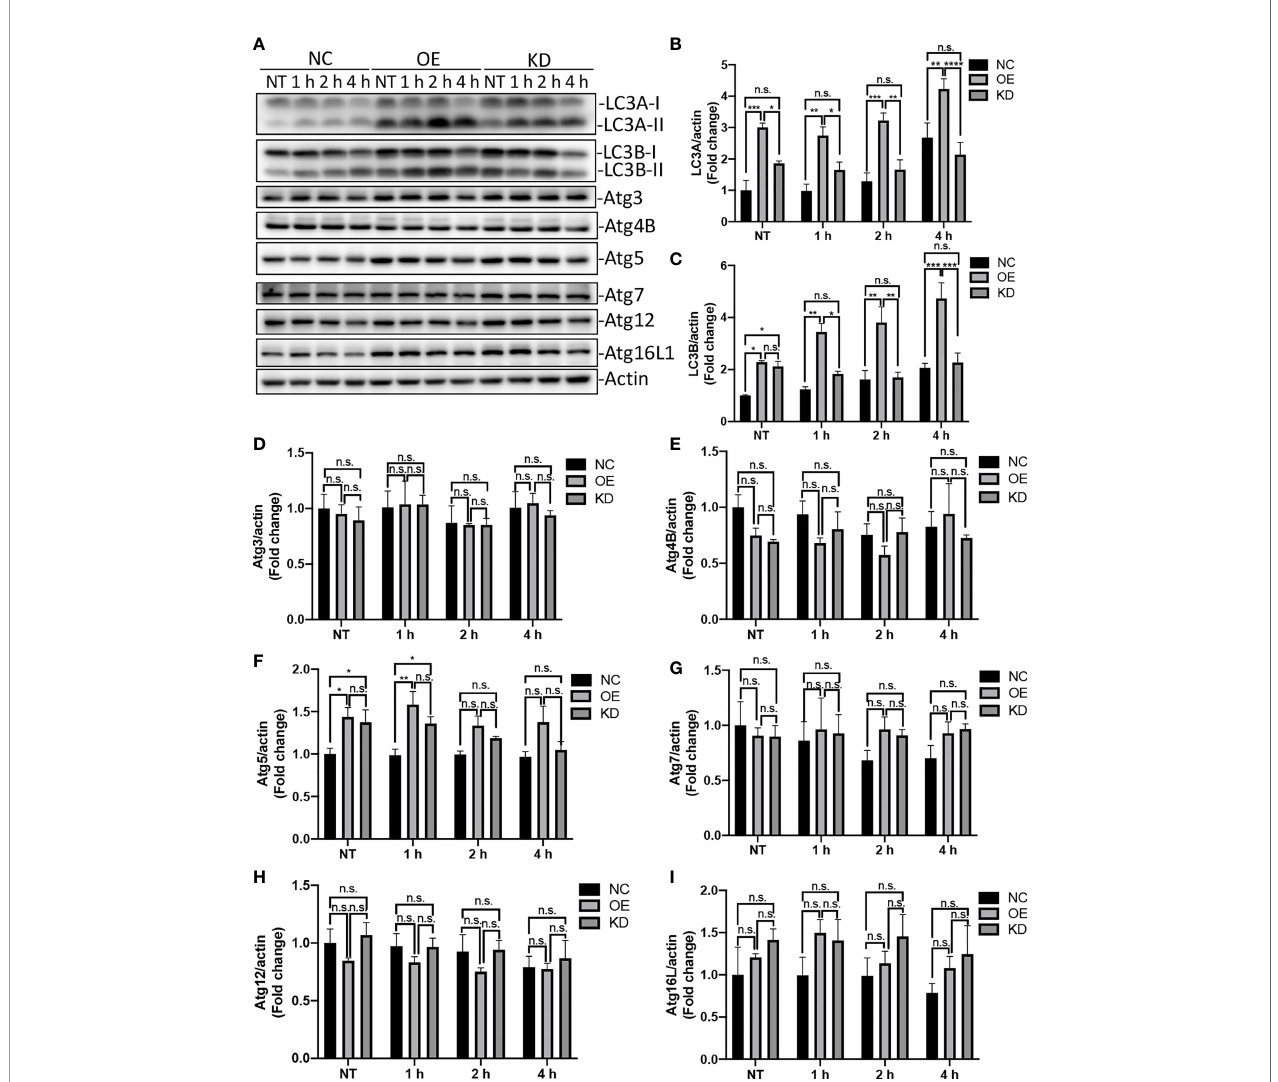
FIGURE 3 | Egr-1 upregulated expression of autophagy-related proteins in macrophages during P. aeruginosa infection. Egr-1 NC, OE and KD RAW264.7 cells were infected with P. aeruginosa PAO1 at an MOI of 10 for 1 h, 2 h, 4 h or left untreated (NT). Cell lysates were subjected to Western blotting for determining the protein expression levels of LC3A, LC3B, Atg3, Atg4B, Atg5, Atg7, Atg12 and Atg16L1, and actin was used as a loading control. Blots are representative of three independent experiments (A) . Densitometry analysis of the protein levels of LC3A (B) , LC3B (C) , Atg3 (D) , Atg4B (E) , Atg5 (F) , Atg7 (G) , Atg12 (H) and Atg16L1 (I) was normalized to actin, and data were presented as fold change (n = 3 ± SEM; n.s., not signi fi cant, *p < 0.05, **p < 0.01, ***p < 0.001, ****p <